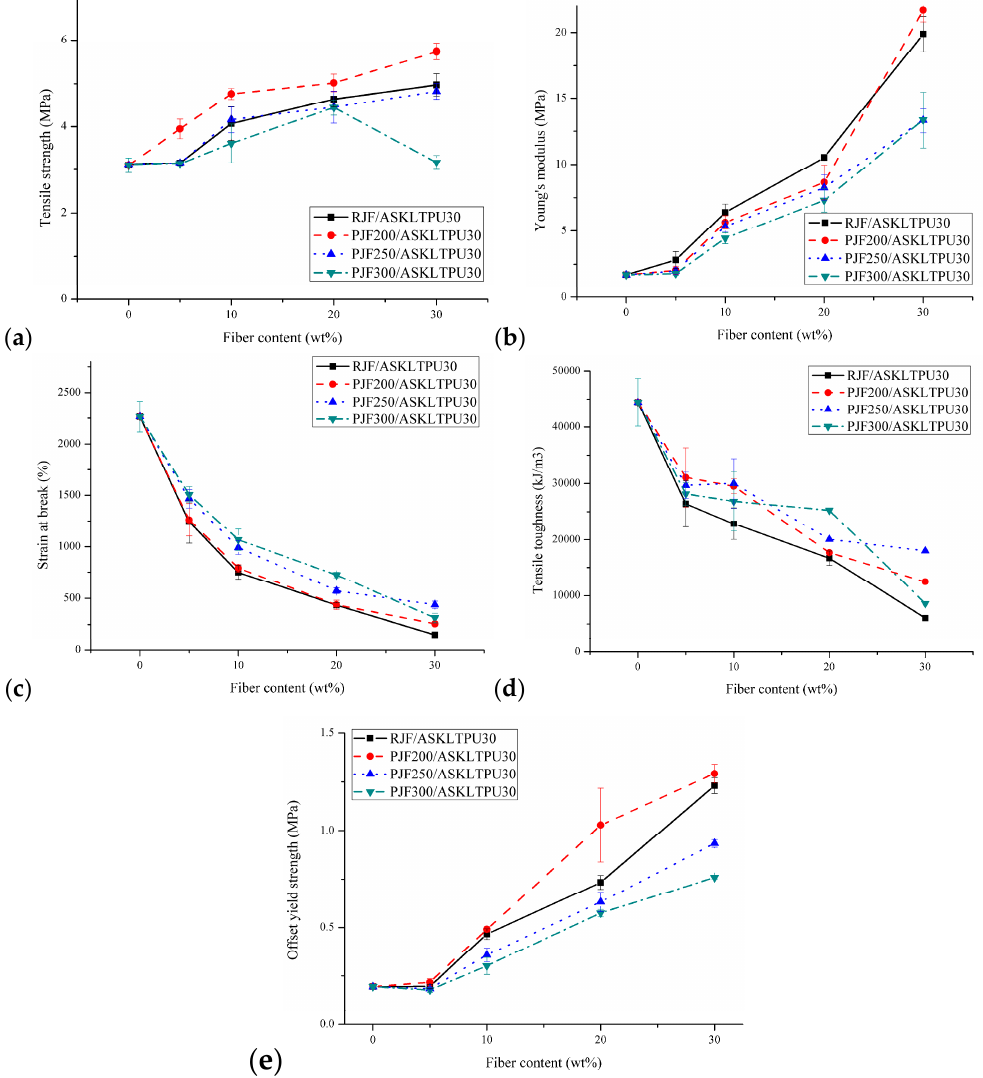
Figure 4. Mechanical properties of JF-reinforced ASKLTPU:( a ) Tensile strength; ( b ) Young’s modulus; ( c ) strain at break; ( d ) tensile toughness; and ( e ) offset yield strength.